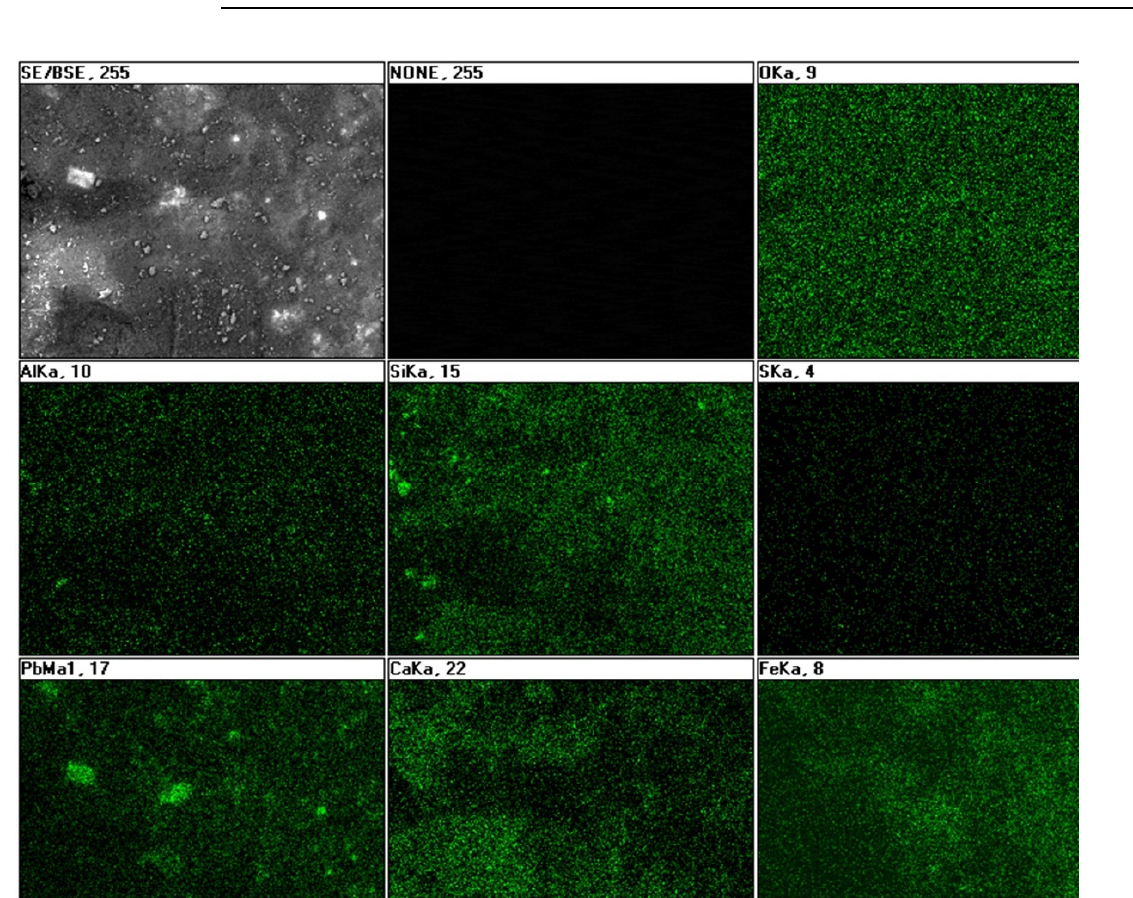
Figure 5. Elementary mapping of a red pigment sample.